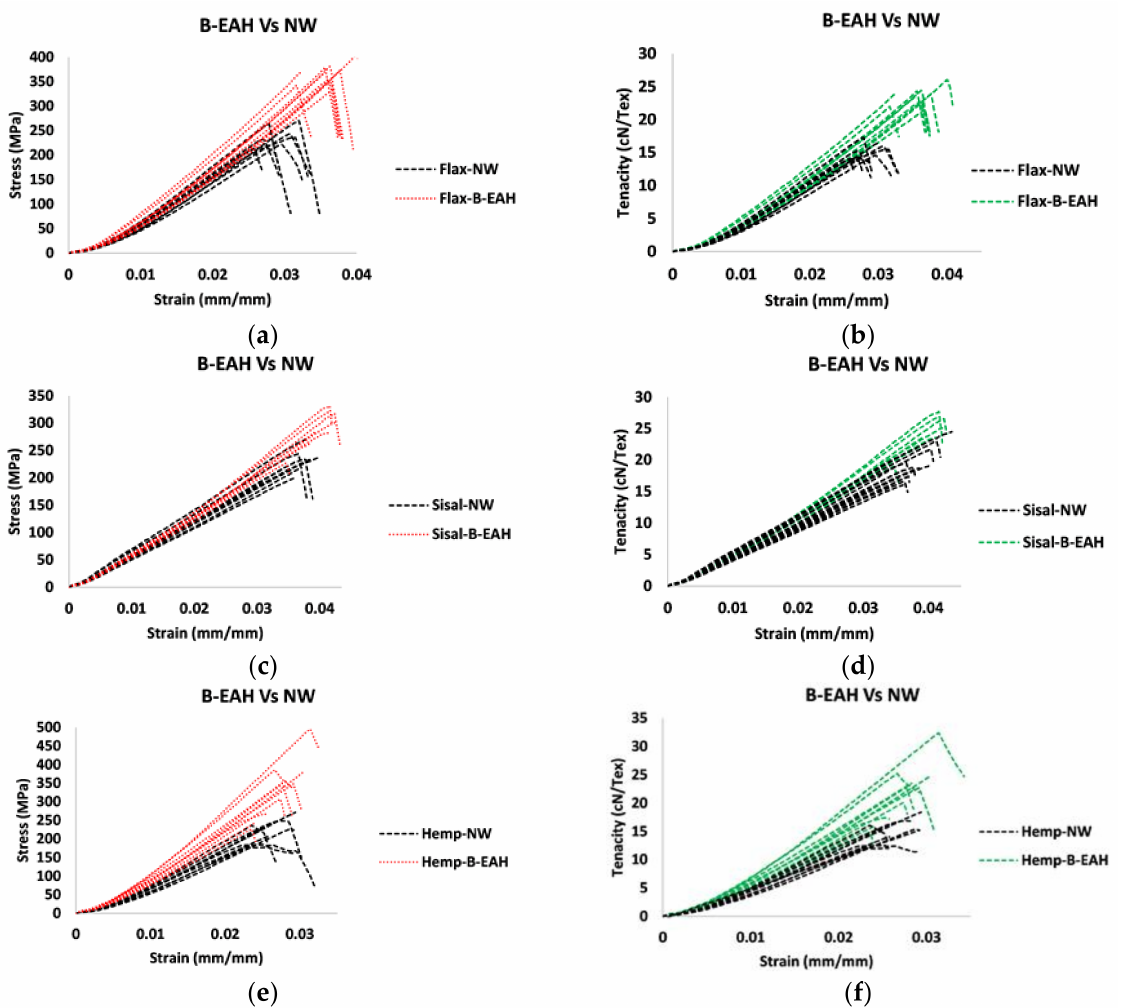
Figure 11. Stress-strain graphs ( a , c , e ) and tenacity-strain graphs ( b , d , f ) of the non-washed and B-EAH-washed fibers for flax, sisal and hemp